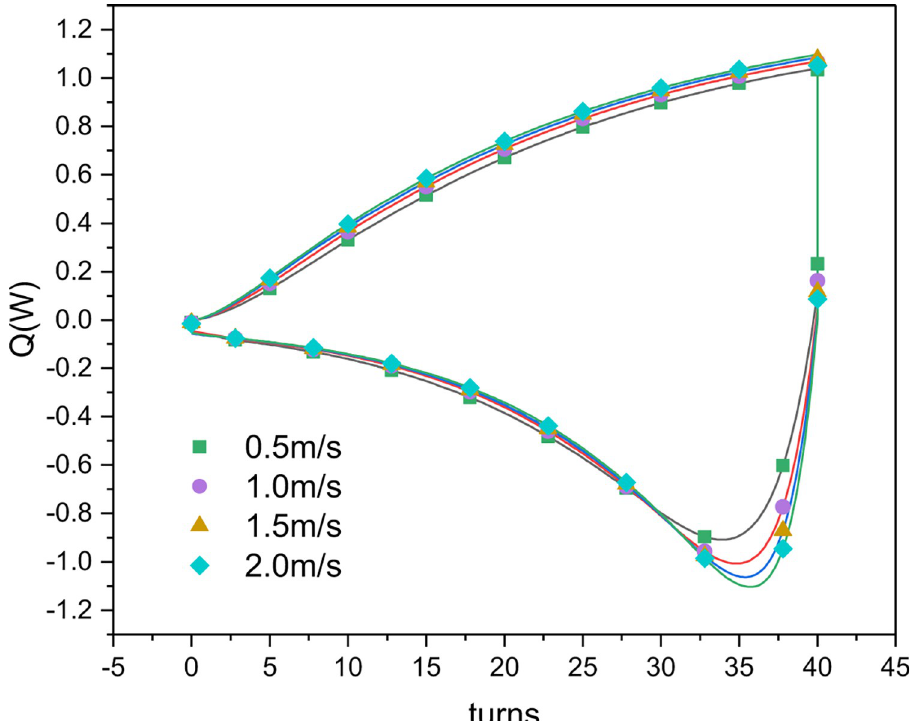
Fig 16. Simulated cooling and heating capacities of the nitinol wires in a nitinol wire-stepping motor unit as functions of airflow rates ( n = 50rpm). 1